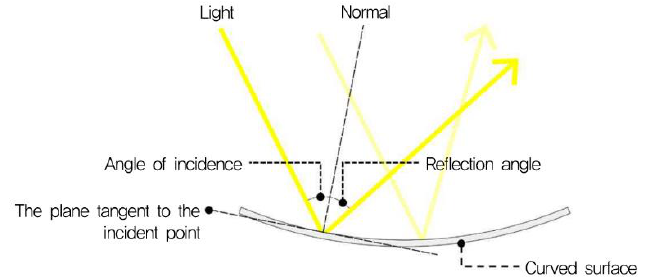
Figure 3. Reflection of light on a curved surface.